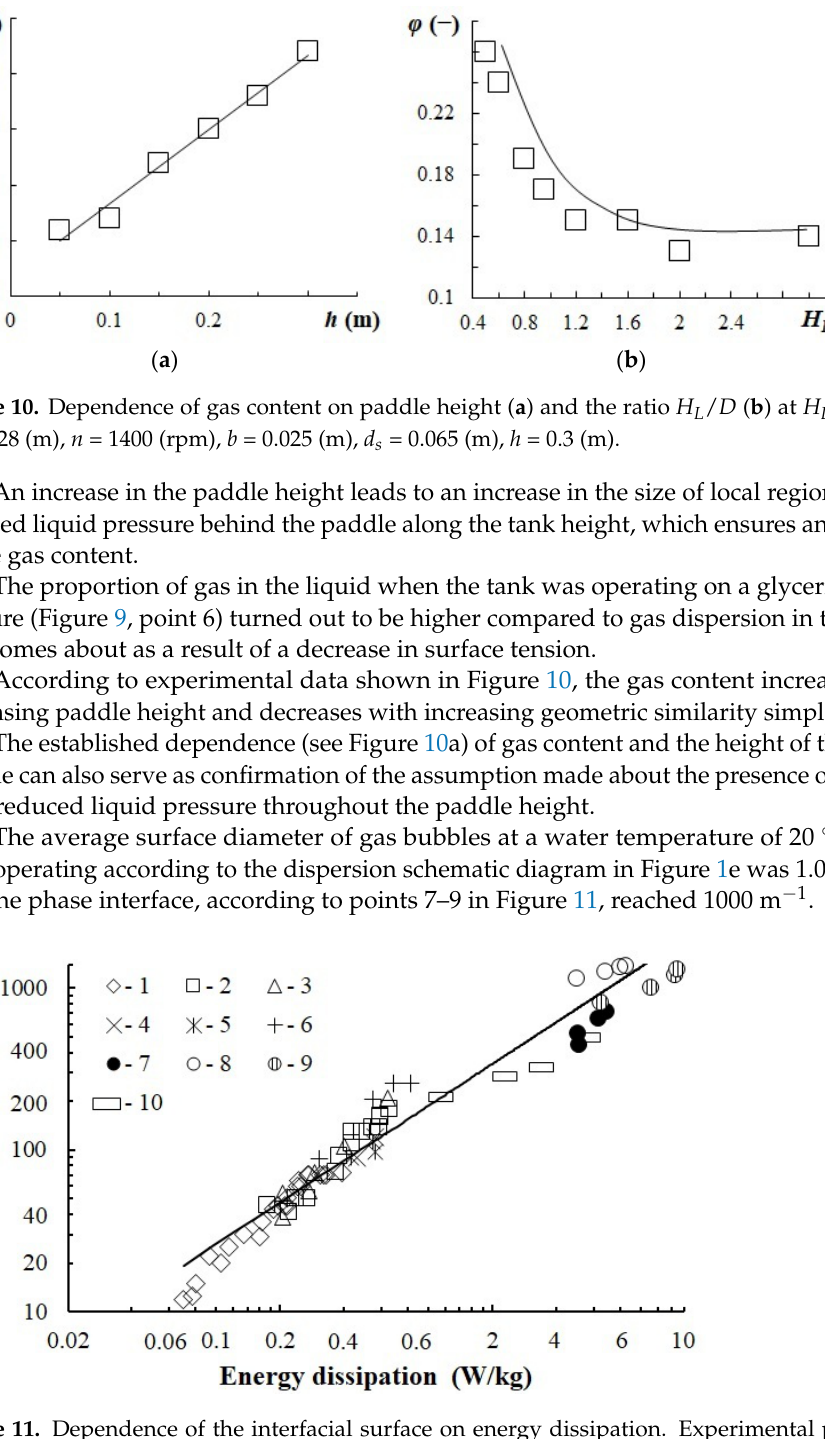
Figure 12. The dependence of the mixing power on the Reynolds number at h = 0.3 (m), one parti- tion, H L / D = 1.2, d s = 0.064 (m), D = 0.28 (m) at n = 600–2400 (rpm).